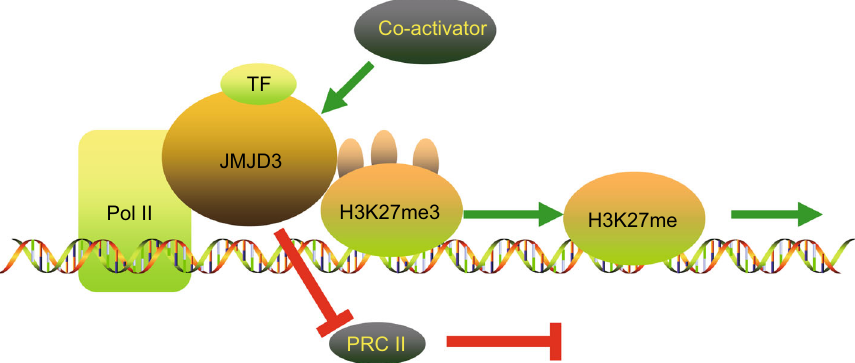
Figure 2. A graphical illustration on the mechanisms of JMJD3 in the regulation of enhancing gene transcription. JMJD3 promotes gene transcription in a demethylase-dependent or independent manner. JMJD3 enhances the initiation of transcription through three ways. Firstly, JMJD3 demethylate H3K27me3 on the promoter of targeted genes. Secondly, JMJD3 releases suppressive PRC2 complexes. Thirdly, JMJD3 binds to the Pol II elongation complex, enhancing its progression through H3K27me3- enriched gene bodies to enhance transcription elongation. This is the demethylase-dependent process. JMJD3 recruits co-activators to targeted gene promoters by interacting with both the co-activator and transcription factors in gene promoters. This co-activation process does not require demethylase activity. This is the